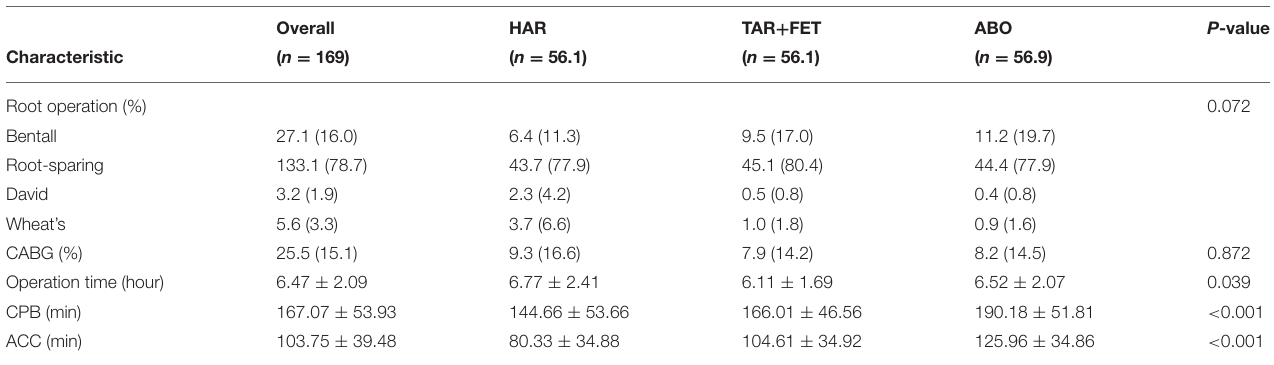
TABLE 4 | Operative variables for the total cohort and each group after using the matching weight method. Overall HAR TAR + FET